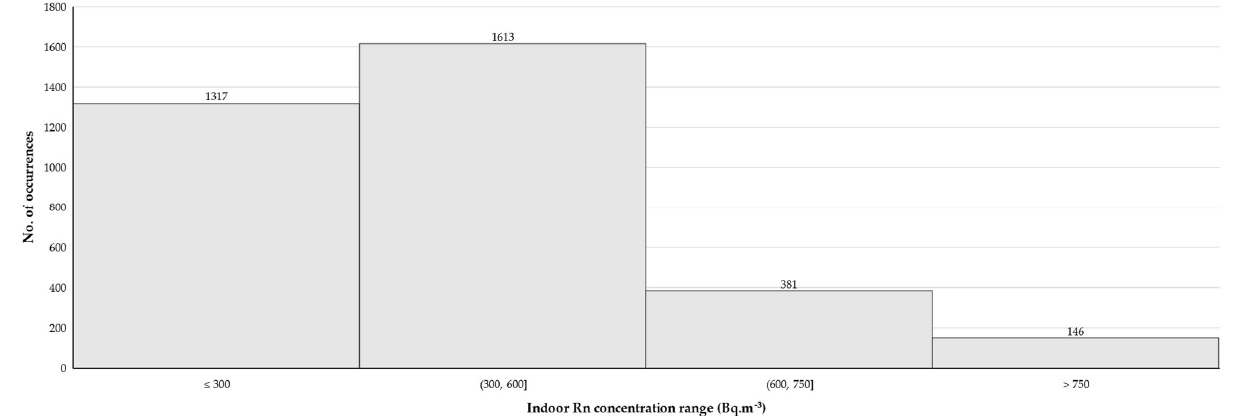
Figure 10. Distribution of measurements taken in the evaluation of Rn concentration in the compartment after mortar application.